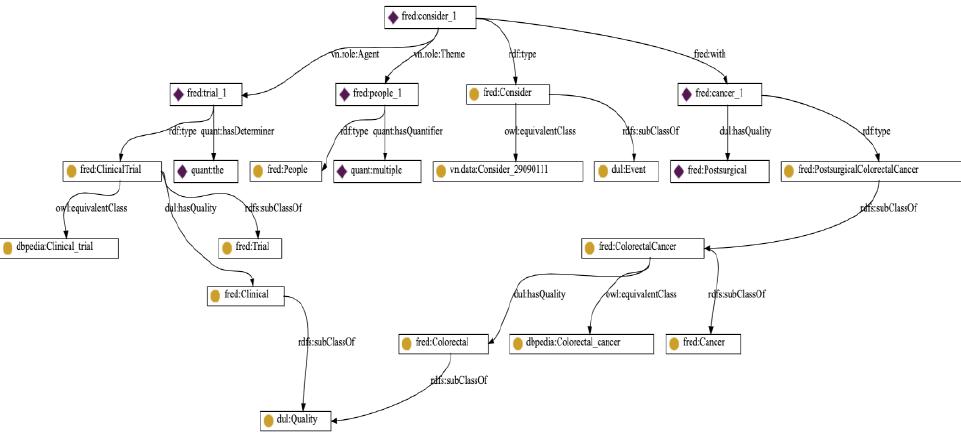
Figure 3. Example of a graph produced by FRED from the sentence, “The clinical trial considers people with postsurgical colorectal cancer.”